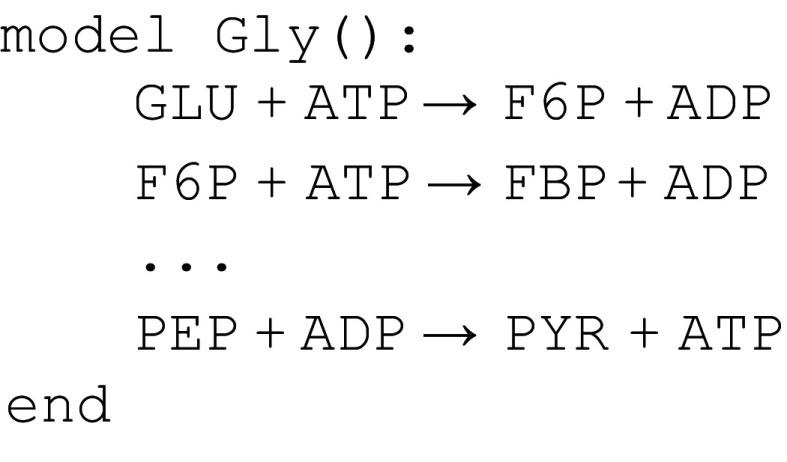
Snippet of the glycolysis model in
33.